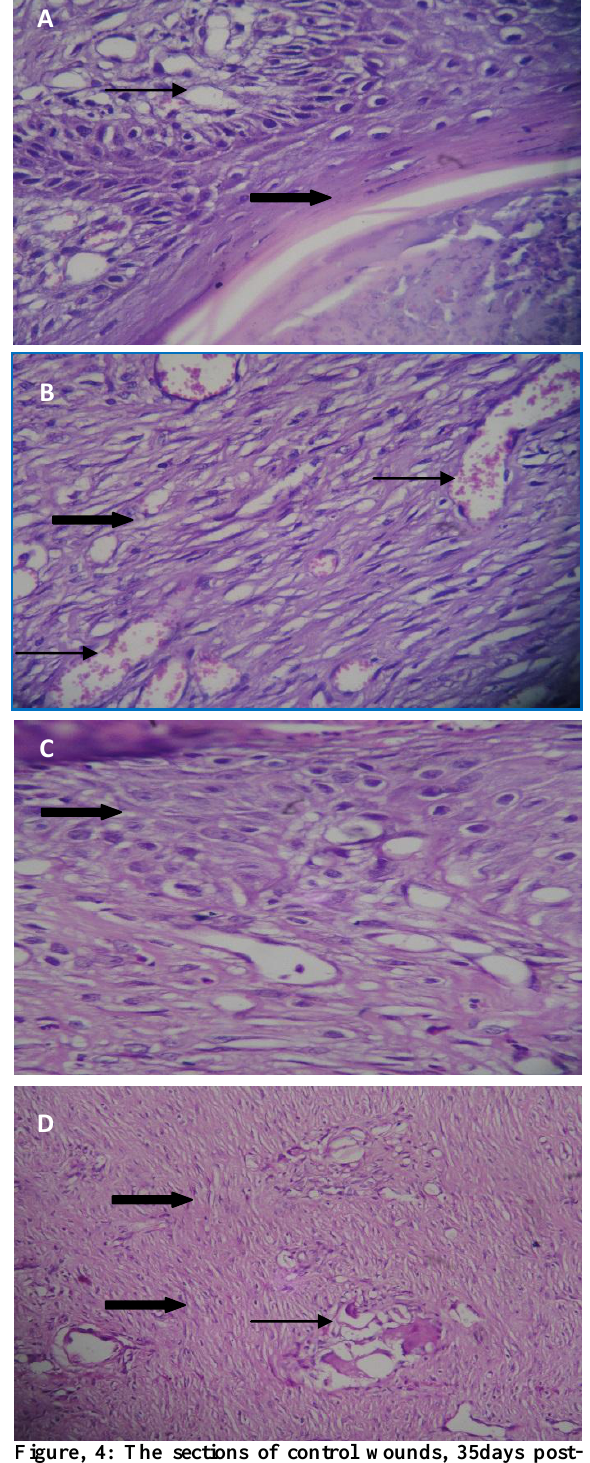
Figure, 4: The sections of control wounds, 35days post- wounding, the lining of incision with slight keratinized mature epithelial layer (thick arrow) that consist of stratum cornium, stratum spongiusum and basali (thin arrow) (A),with proliferation of fibrous connective tissue (thick arrow) containing of congested B.Vs. (thin arrows) (B). More mature epithelial layer lining the incision (thick arrow) (C), large amount of mature granulation tissue fill the dermis (thick arrows), associated with number of myofibroblasts plus giant cells formation (thin arrow) (D) are notice in the sections of treated wounds, 35days post- wounding (H and E,